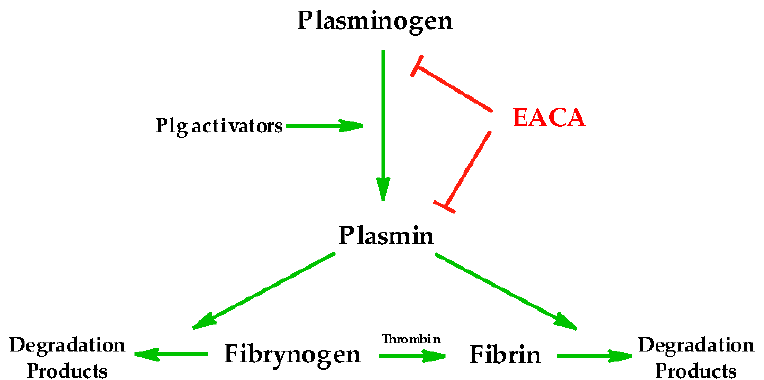
Figure 2. Scheme of the plasminogen–plasmin system. Inactive plasminogen is converted into plasmin as a result of an action of plasminogen activators (natural: urokinase plasminogen activator or tissue plasminogen activator, or synthetic: streptokinase). Plasmin then enables the degradation of fibrinogen (a plasma protein) as well as the degradation of the fibrin clot into fibrin cleavage products. The unbound circulating fibrinogen is converted into fibrin clot by thrombin. The formation of plasmin from plasminogen can be inhibited by antifibrinolytic drugs (Ahx). The interaction of Ahx with plasminogen or plasmin, as well as plasmin with fibrin or fibrinogen, is mediated by lysine binding sites, not enzymatic active sites of plasmin. Green arrows = activation, red arrows = inhibition.